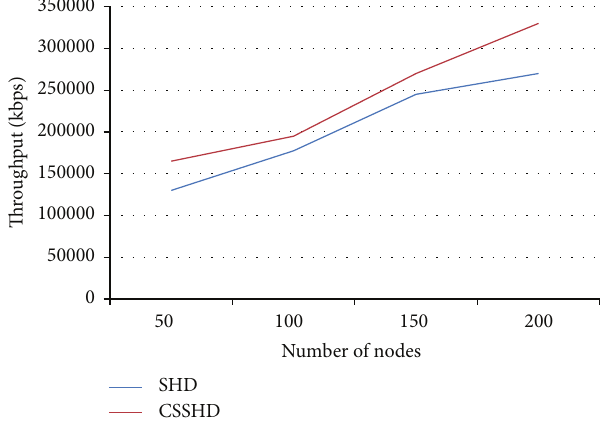
Figure 10: Graph for